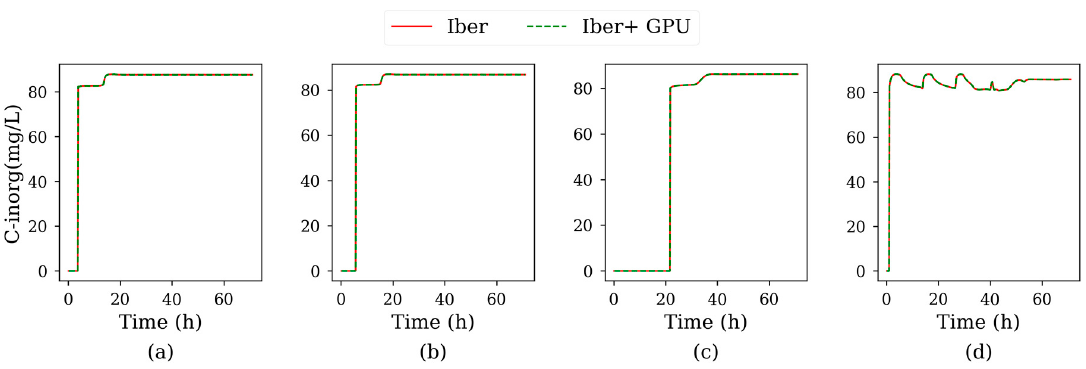
Figure A7. Time series of alkalinity for Test 4, sampled at control points P1 ( a ), P2 ( b ), P3 ( c ) and P4 ( d ).